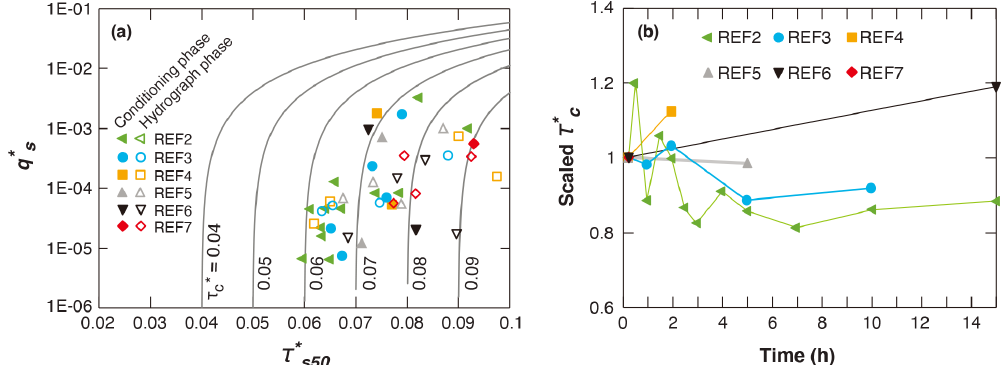
using surface median grain size for measured transport rates Figure 9. (a) Dimensionless sediment transport rate q ∗ s vs. Shields number τ ∗ s50 (points). Also shown are lines for the Wong and Parker (2006) type equation (Eq. 1) using different values for τ ∗ c . (b) Temporal adjustment of scaled τ ∗ c ( τ ∗ c over τ ∗ c at 15min) during the conditioning phase. Here τ ∗ c is back-calculated using Eq. (1) (Wong and Parker, 2006,